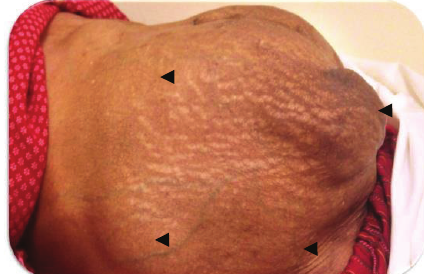
Figure 1: Multiple intra-abdominal masses as shown by arrow heads.